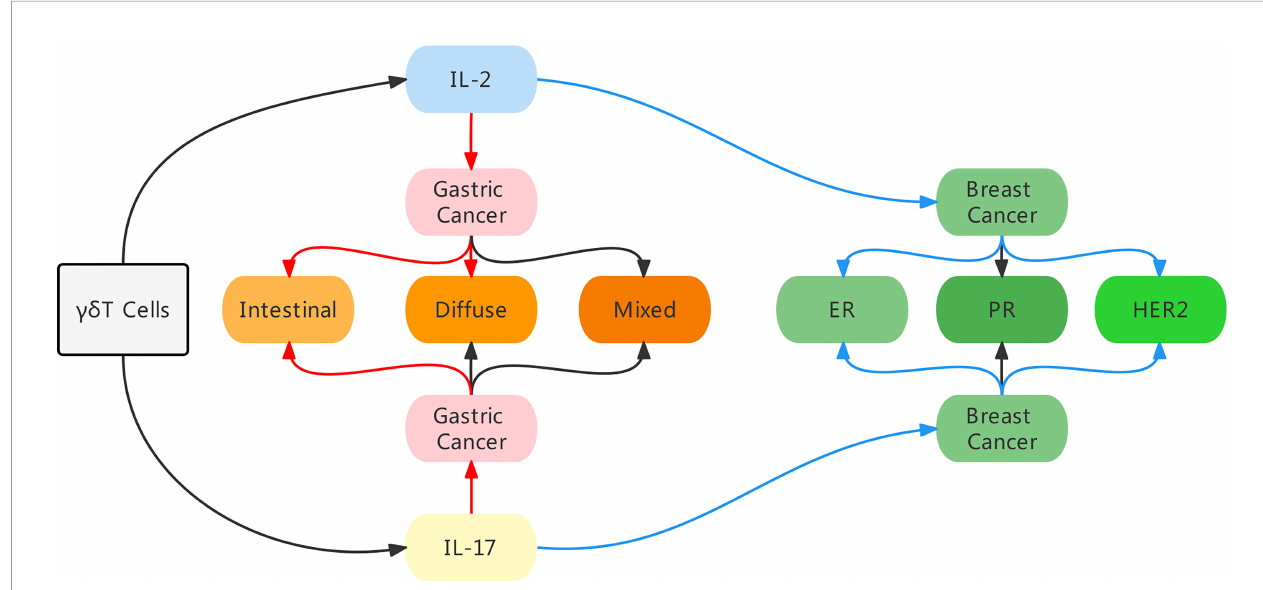
FIGURE 7 | An illustration of the main fi ndings in our study. By bibliometric analysis, we identi fi ed IL-17 and IL-2 as the most common cytokines linked to gd T cells, and these two cytokines in fl uenced the prognosis in different manners in gastric cancer and breast cancer. In breast cancer, high expression of IL-2 and IL-17 indicated a better prognosis, especially in ER negative and HER2 negative patients. While in gastric cancer patients, high level of IL-2 indicated a worse prognosis in intestinal and diffuse conditions, and high level of IL-17 was merely predictive of a poor prognosis in intestinal condition. Red arrow indicates a poor prognosis, blue arrow indicates a good